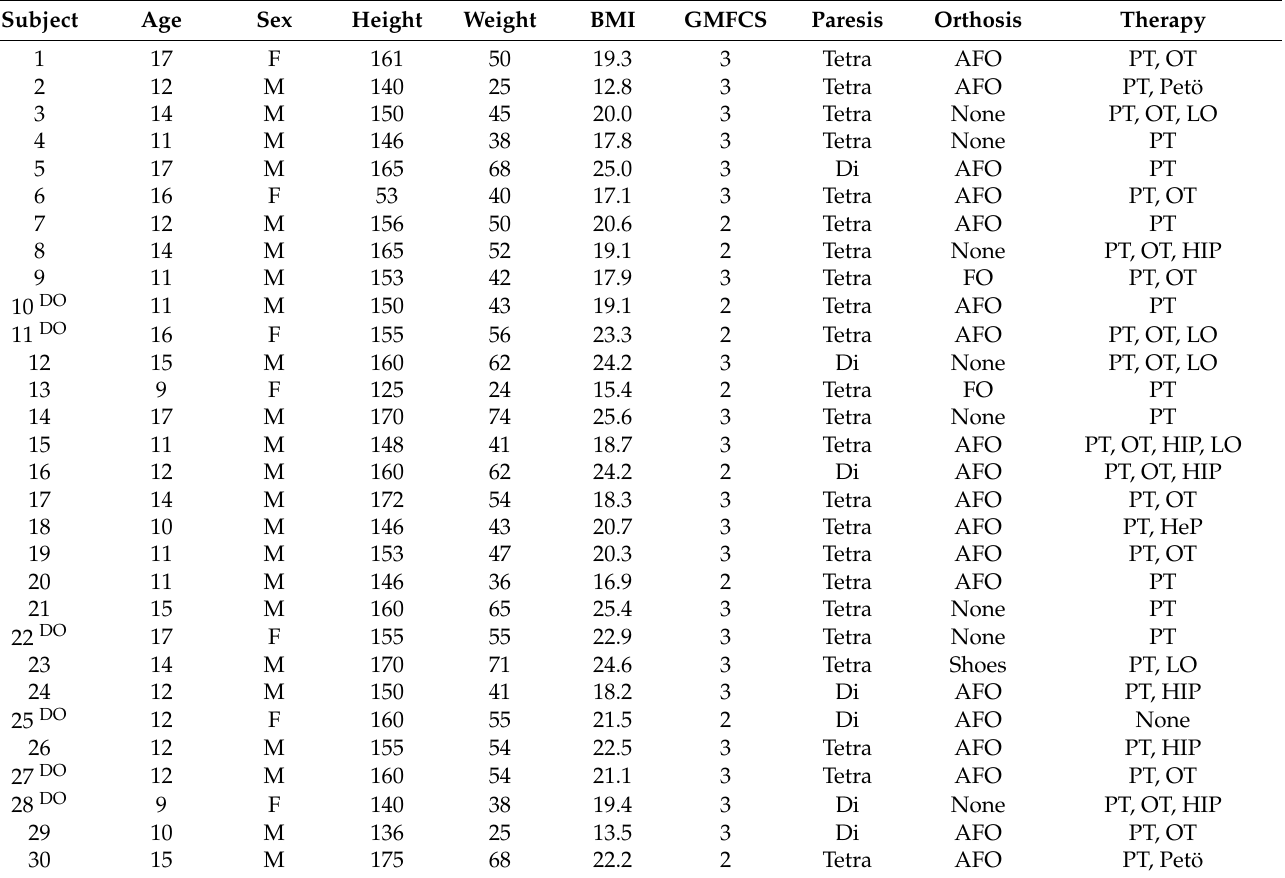
Table 3. Overview of subject characteristics. GMFCS: Gross Motor Functions Classification System.